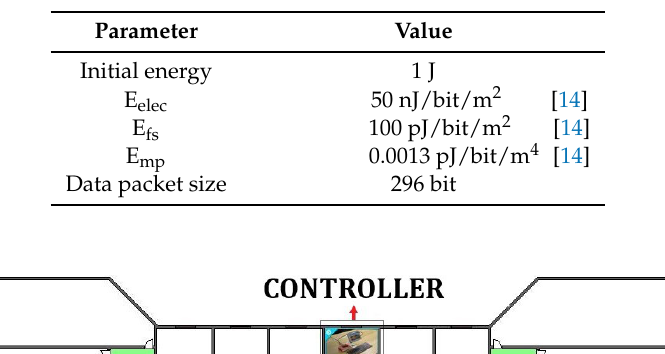
Table 1. Energy parameters.